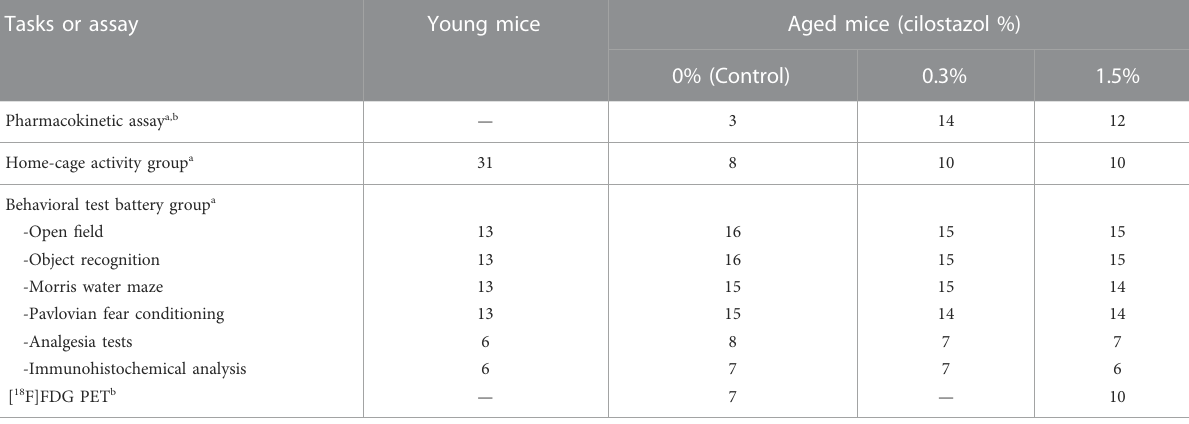
TABLE 1 Number of subjects used in this study. Tasks or